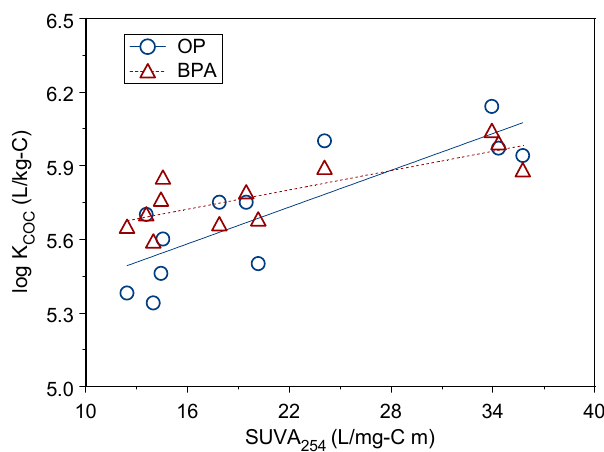
Figure 4. Linear correlation between log K COC and SUVA 254 for OP and BPA.